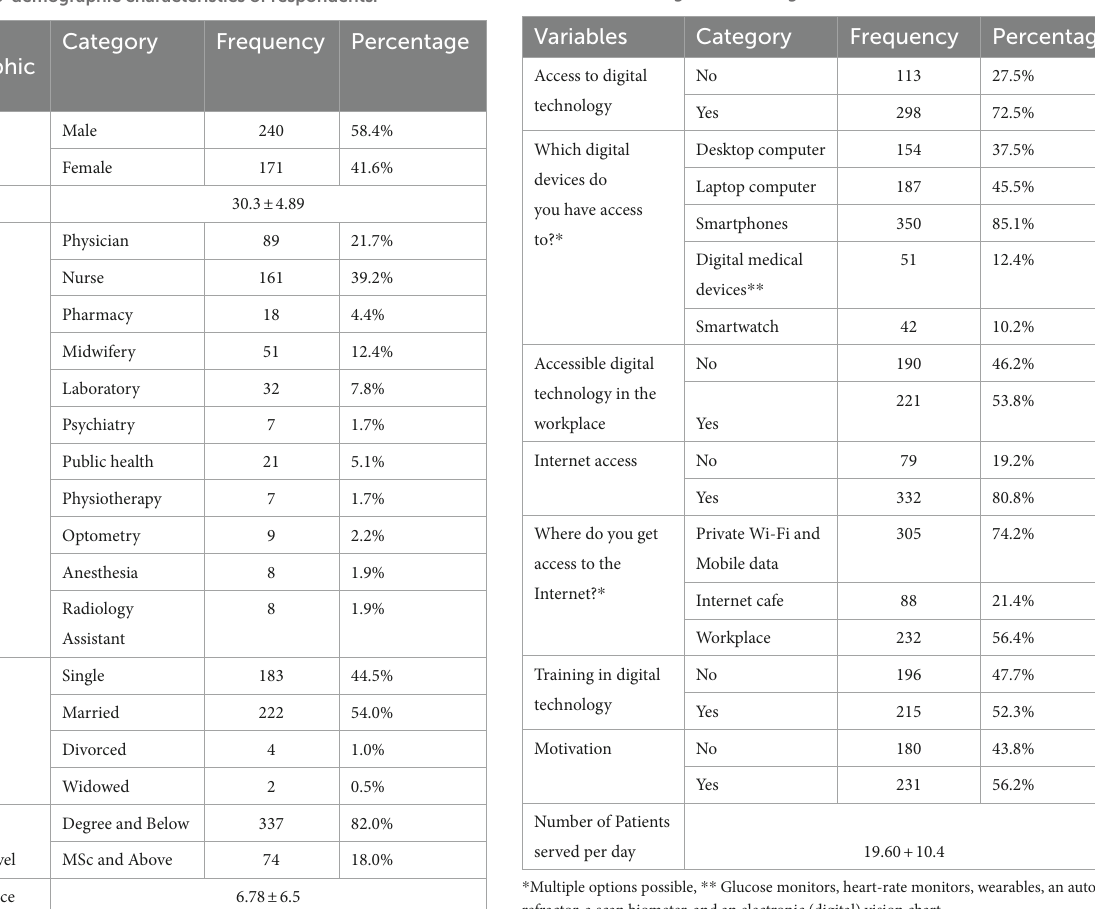
TABLE 2 Technological and